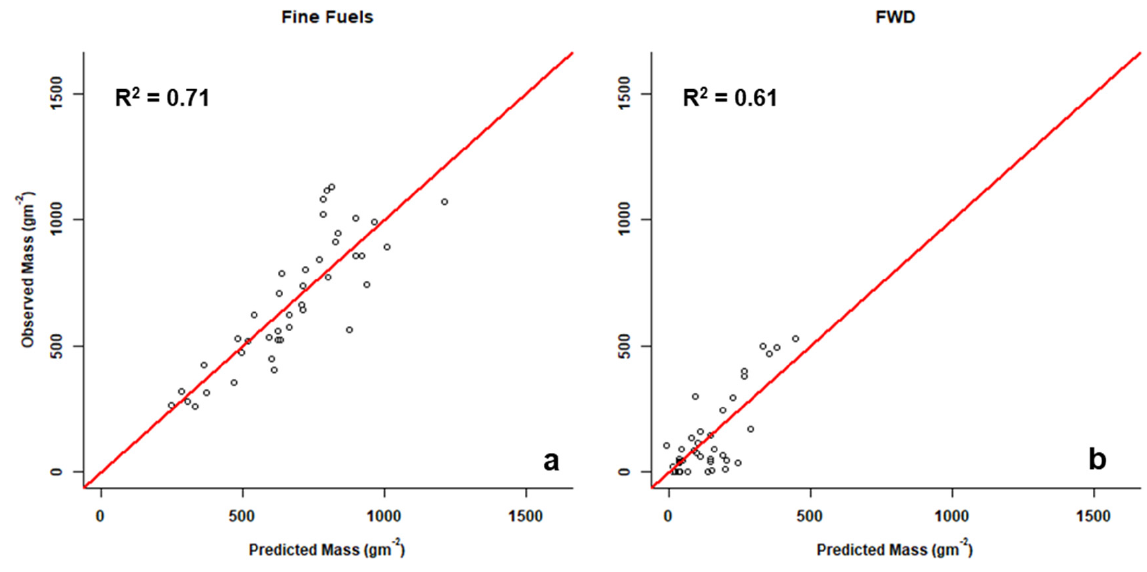
Figure 4. Observed vs. predicted surface biomass comparing the fine fuels ( a ) and fine woody debris ( b ) vegetation and fuel mass classes and their respective linear models.